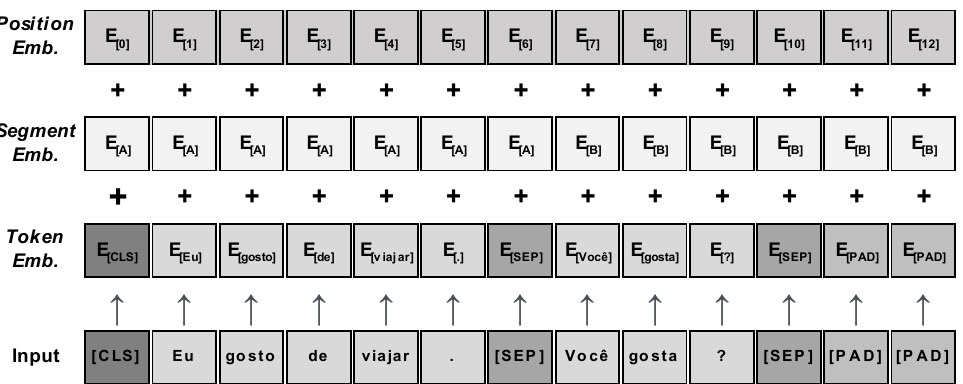
Figure 2. Embedding composition.